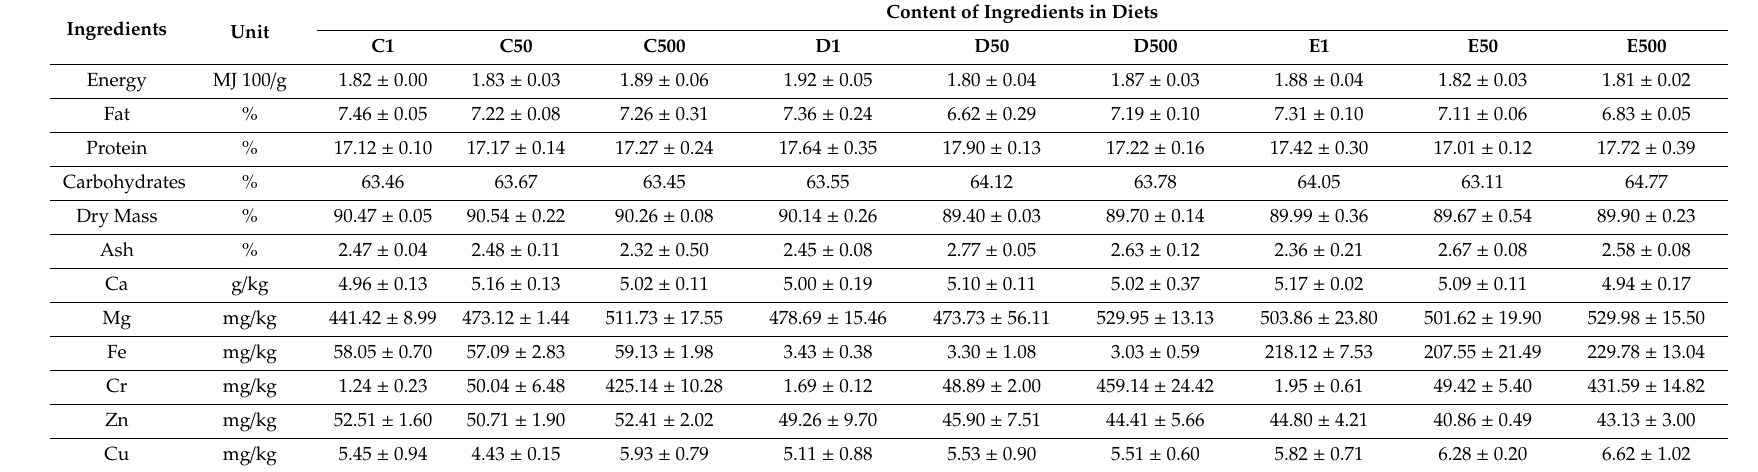
Table 1. The chemical composition of diets (mean ±